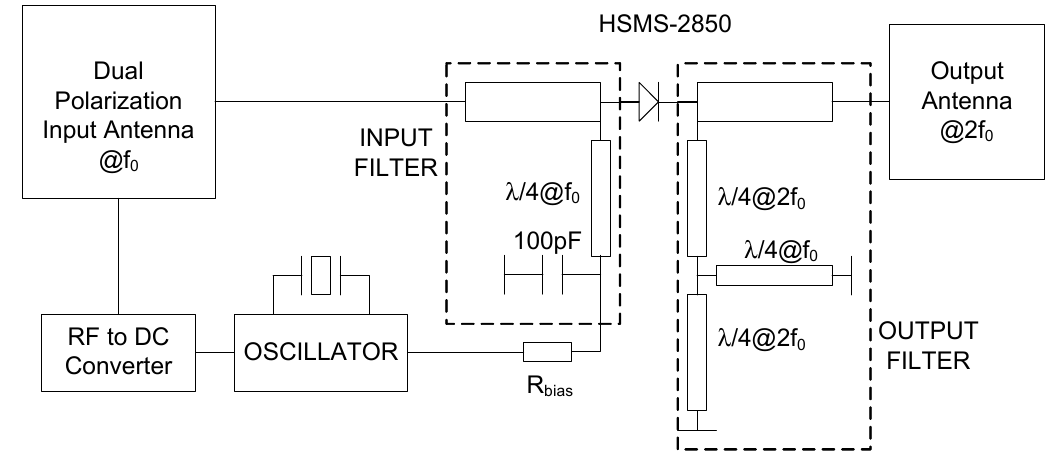
Figure 2. Block diagram of the tag designed.